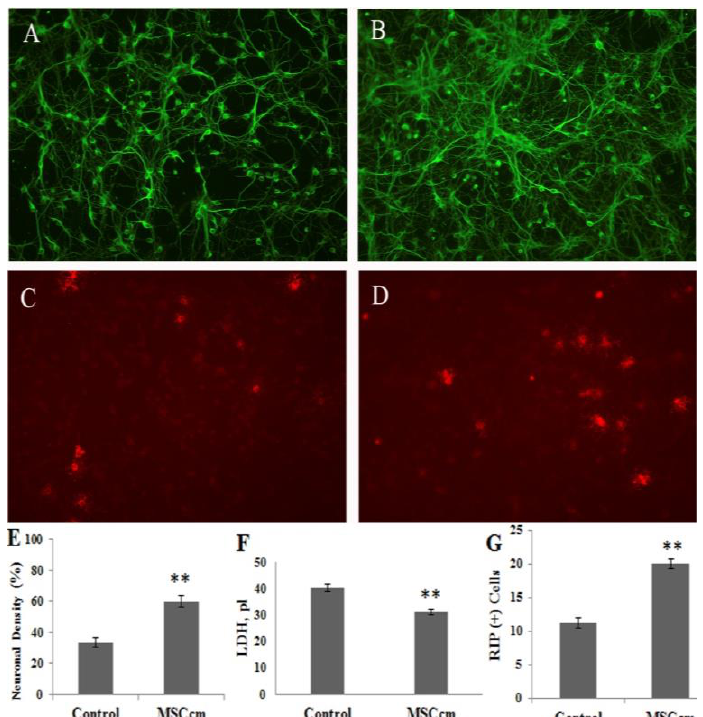
Figure 2. Beneficial effect of bone marrow mesenchymal stem cells (BM-MSC) conditioned medium (MSCcm) on cell survival in spinal cord neuron–glial cultures. ( A ) Beta III tubulin (+) neuronal connection of neuron–glial cultures. ( B ) Neuronal connection of MSCcm-treated neuron–glial cultures. ( C ) Rip (+) oligodendrocytes in neuron–glial cultures. ( D ) Oligodendrocytes in MSCcm-treated neuron–glial cultures. ( E ) Quantification of neuronal density of A and B. ( F ) Lactate dehydrogenase (LDH) release in the neuron–glial culture medium. ( G ) Quantification of oligodendroglial density of C and D. Data represent the mean ± SEM. ** p < 0.01, indicate significant difference between saline control and MSCcm treatment.